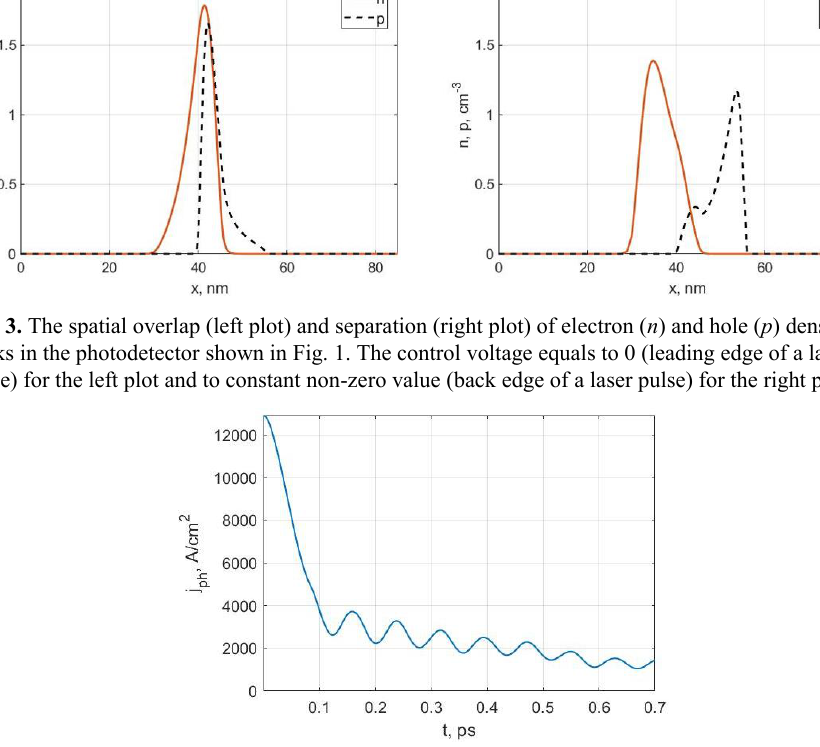
Fig. 4. The dependence of photocurrent density on time during the back edge of a laser pulse. This photocurrent flows through the supply contacts of the photodetector with controlled relocation of carrier density